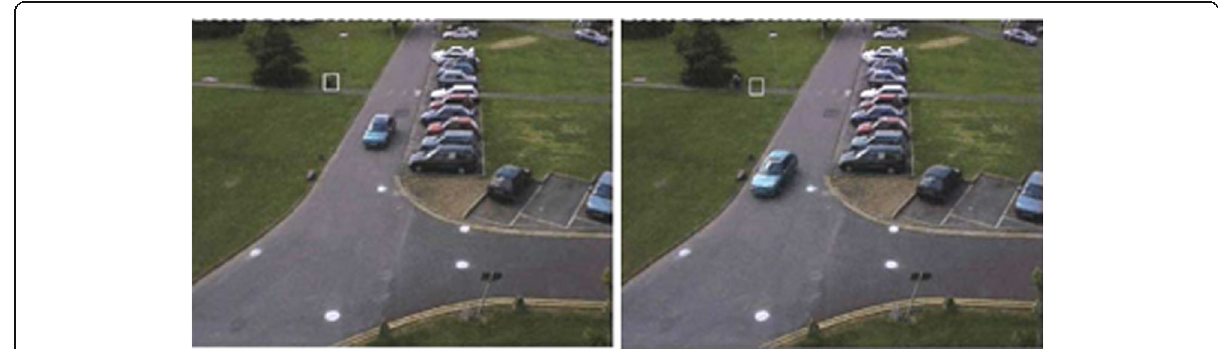
Fig. 10 Performance of mean-shift algorithm in object tracking (from collection of PETS2001 databases [48])